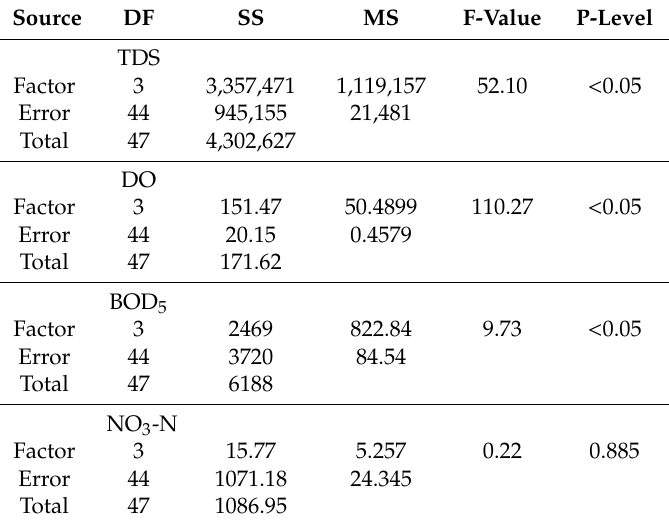
Figure 5. The FWRI versus IWQI at the selected stations over the period from September 2013 to August 2014, ( a ) S. No. 1, ( b ) S. No. 2, ( c ) S. No. 3, ( d ) S. No. 4. Table 7. ANOVA results for the four Table 8. Statistical properties of FWRI and IWQI values at the four stations.